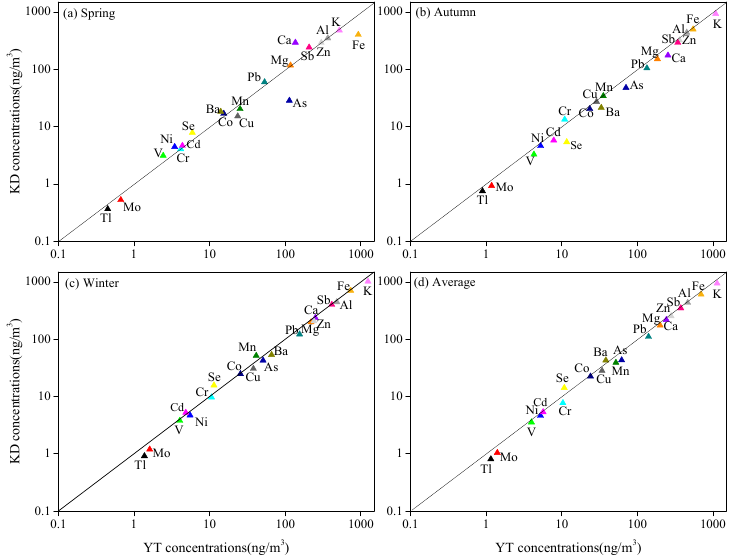
Figure 5. Seasonal mean concentrations of metal elements in spring ( a ), autumn ( b ), winter ( c ), and their average concentrations during the sampling periods ( d ) at the YT and KD sites.